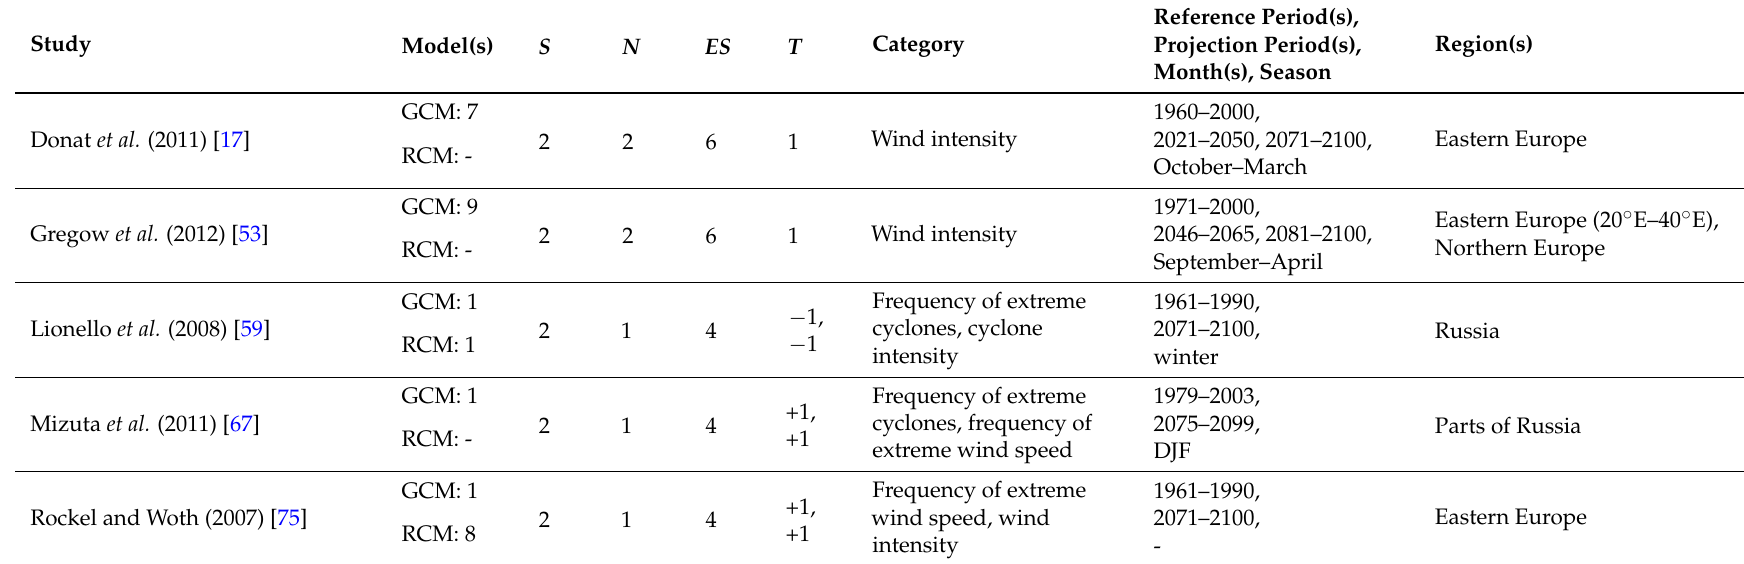
Table 7. Same as Table 1 but for the Eastern Europe